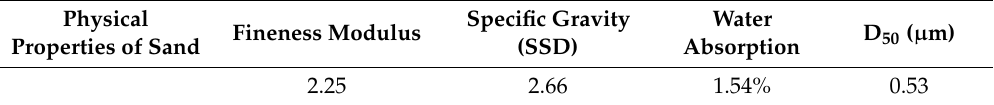
Table 2. Properties of